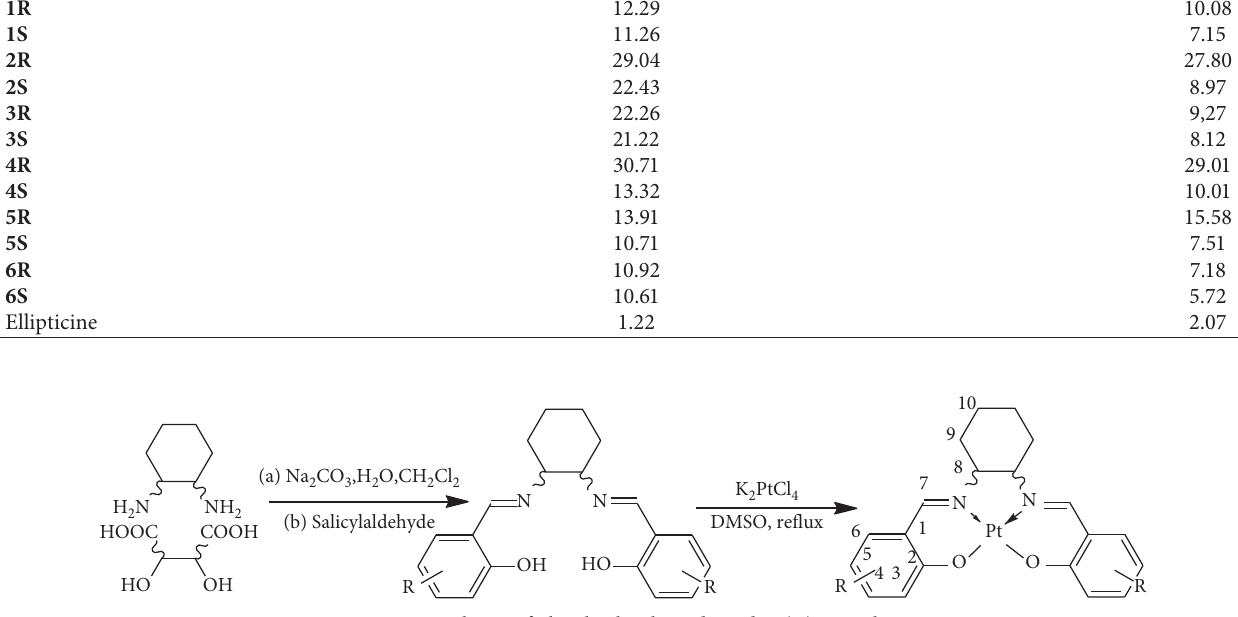
Figure 1: Synthesis of chiral salen ligands and Pt(II) complexes. Table 3: Chiral salen ligands and their Pt(II)